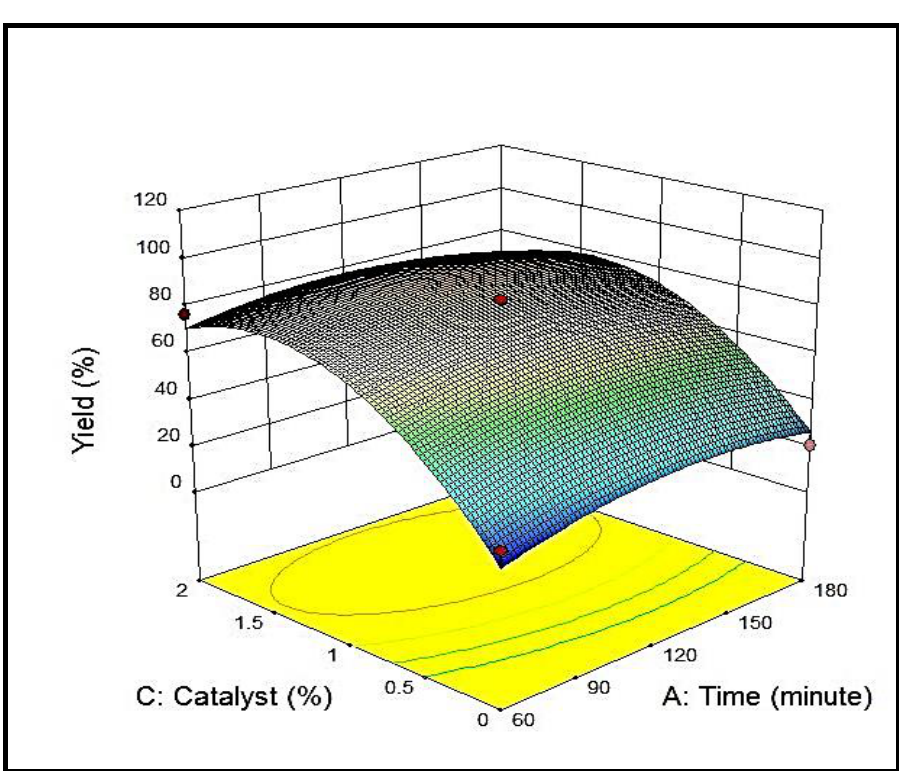
Figure 6. Biodiesel yield (%) vs. CC (%) and reaction time (minutes) .